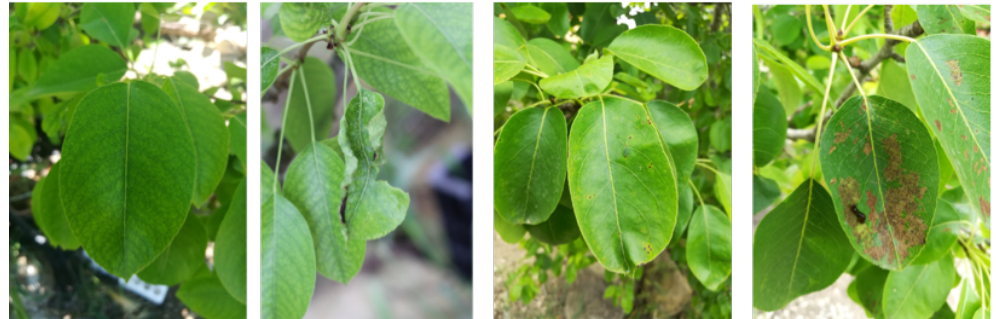
Figure 1. Sample images of the collected dataset.